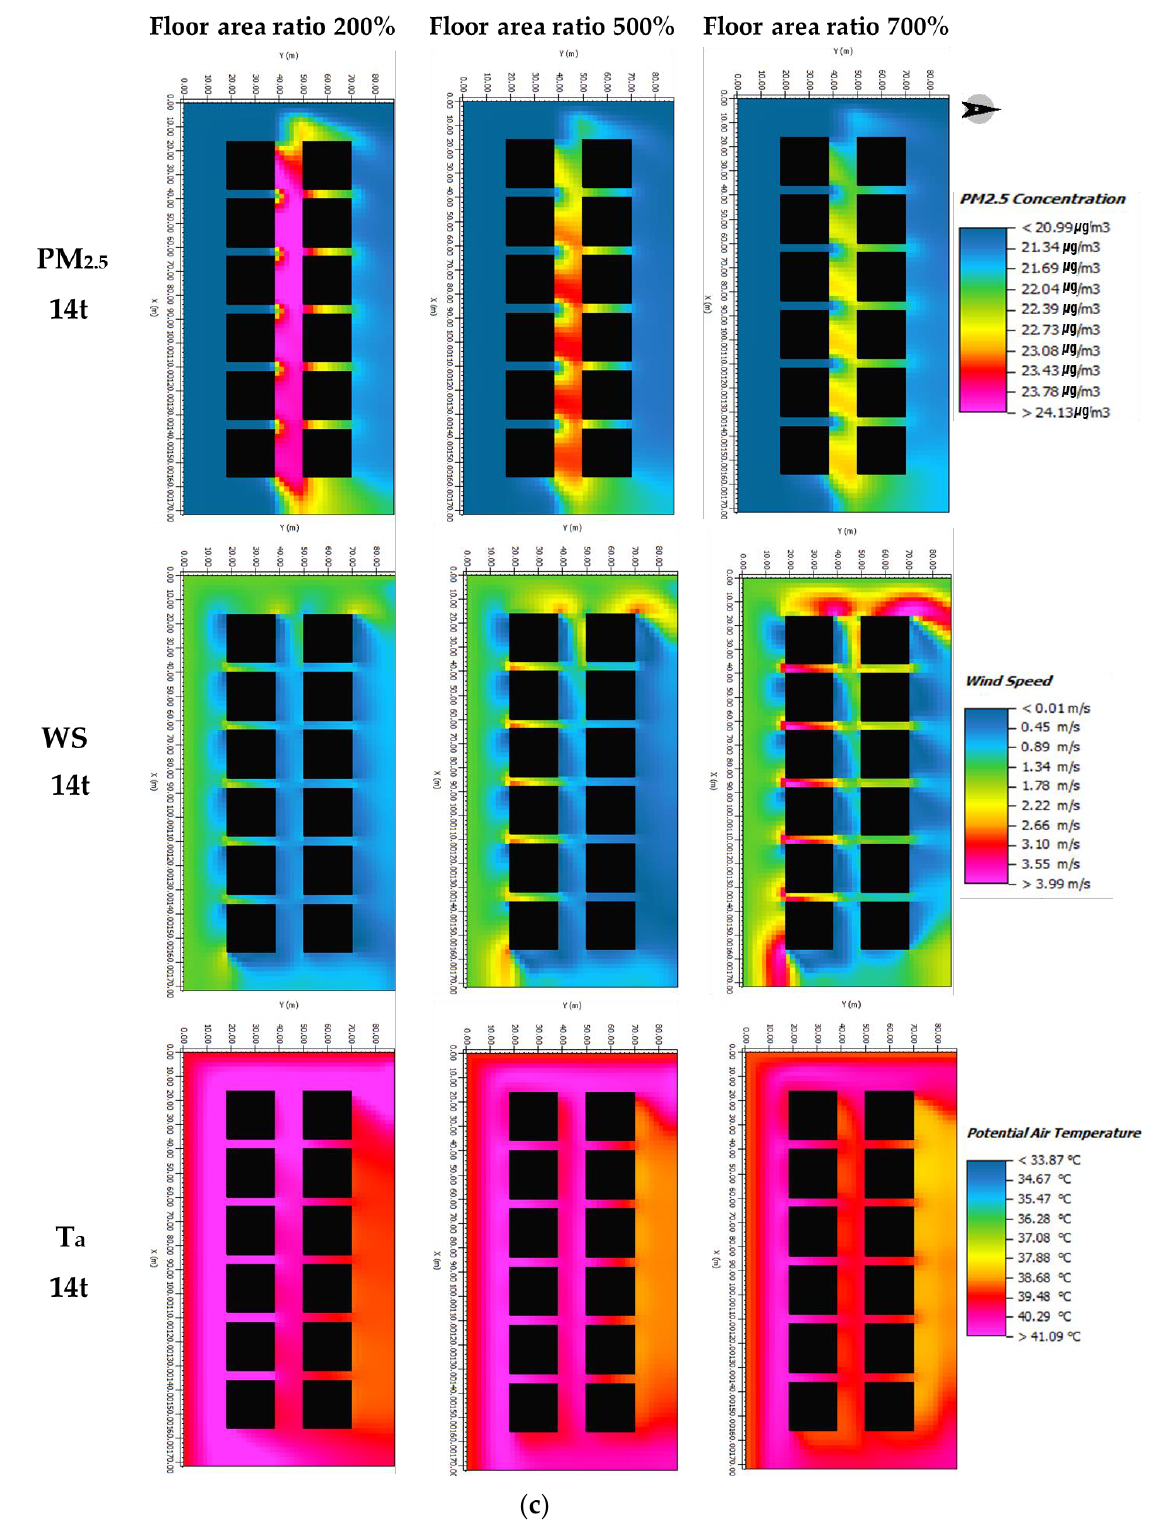
Figure 6. ( a ) Analysis result of high concentration PM according to floor area ratio (PM2.5, WS, Ta). ( b ) Analysis result of extreme cold according to floor area ratio (PM 2.5 , WS, T a ). ( c ) Analysis result of extreme heat according to floor area ratio (PM 2.5 , WS, T a ). PM 2.5 and PM 10 were observed to increase when the floor area ratio was lower dur- ing periods of high-concentration PM and extreme cold (the difference in PM 2.5 is ap- proximately 0.91 μg/m 3 and that in PM 10 is approximately 1.90 μg/m 3 ). In particular, during extreme cold, the change in PM 2.5 and PM 10 values according to the change in the floor area ratio was large (difference in PM 2.5 is approximately 2.23 μg/m 3 and that in PM 10 is approximately 4.52 μg/m 3 ). During extreme heat, a slight difference in PM con-